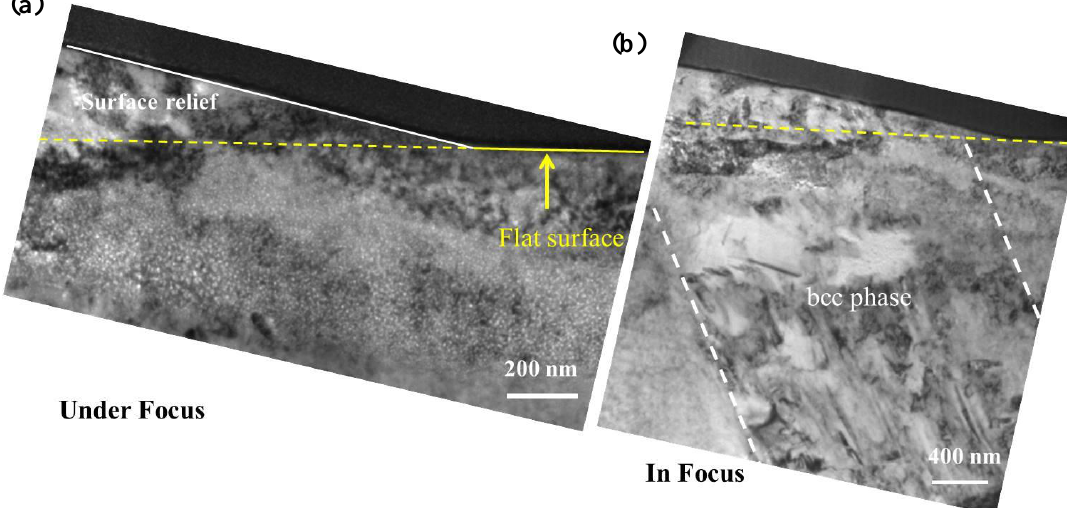
Figure 9. TEM images of the microstructure of the Fe-15Cr-15Ni alloy cryogenically treated at 77 K and heated to 773 K for a 2 × 10 17 ions cm −2 He + irradiation—showing the α’-martensite phase (transformation) that is related to the surface relief at ( a ) high magnification and ( b ) low magnification.